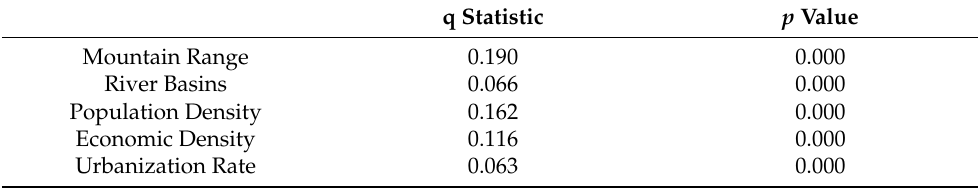
Table 6. The results of Factor